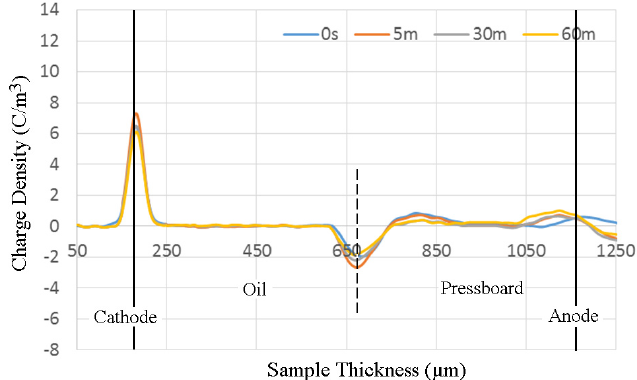
Figure 29. Volt ‐ on results of space charge in fresh oil combined with impregnated pressboard insulation system under AC/DC combined stresses at 261°.